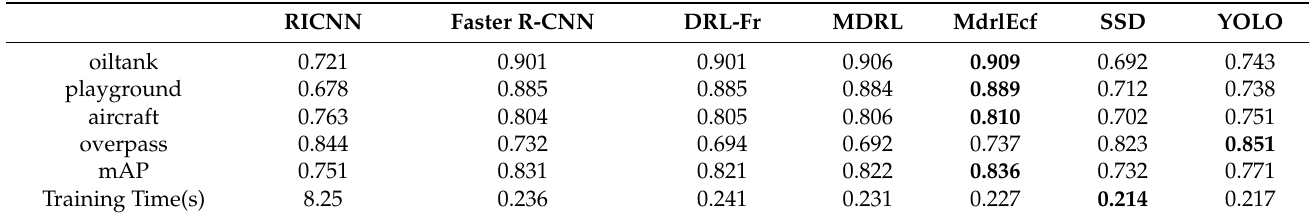
Table 5. Comparison of detection accuracy of different models on the RSOD